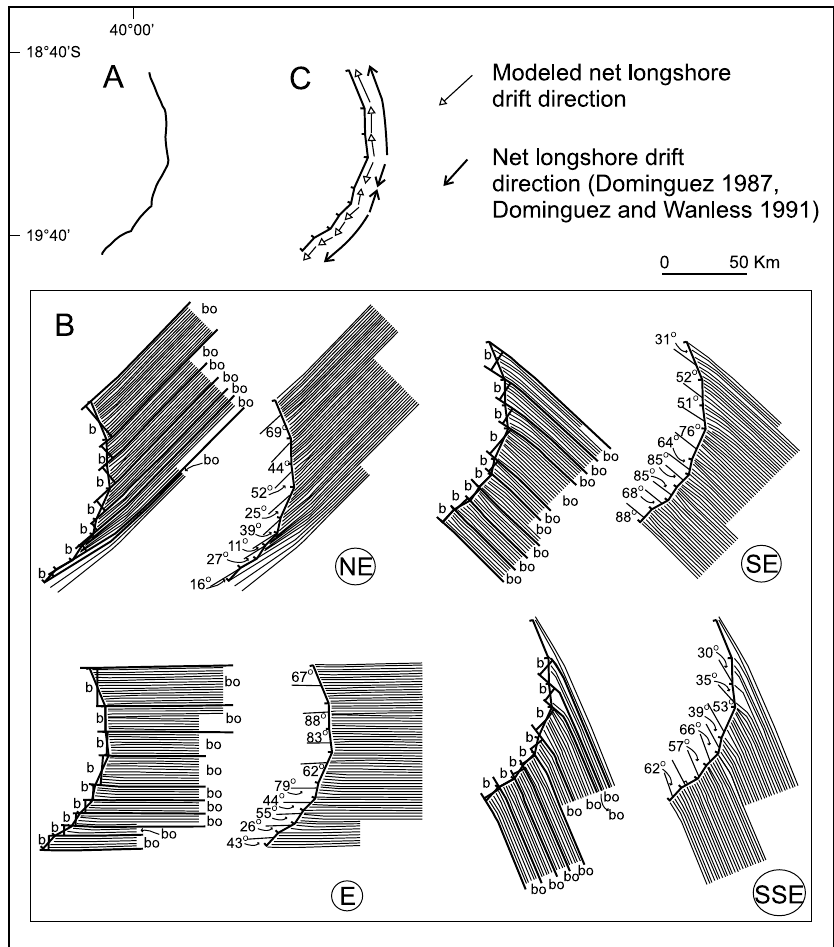
Fig. 6 – (A) Coastline in the Doce River around 3800 cal yr BP (see Fig. 3). (B) Refraction diagrams for waves with a 5-s period, coming from NE and E, and 6,5-s period, coming from SE and SSE. Here are also shown: 1) different segments into which the shoreline was rectilin- earized, 2) incidence angles formed by the wave-rays in relation to the coastal segments and 3) measurements of b and b o (see text) used to estimate wave height along the shore segments. (C) Rectilinearized shoreline showing the directions of net longshore drift of sediments estimated from numerical modeling and from Dominguez (1987) and Dominguez and Wanless